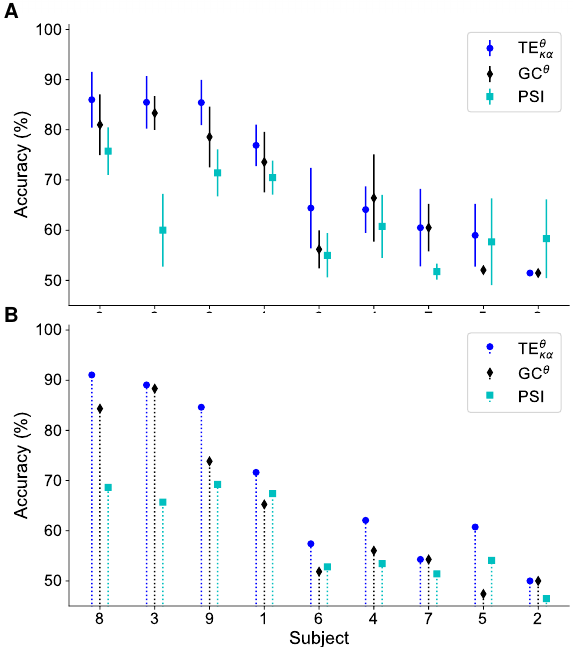
Figure 7. ( A ) Highest average classification accuracy for each subject in the MI database during the training-validation stage. ( B ) Accuracies obtained for each subject during the testing stage. The subjects are ordered from highest to lowest performance according to the accuracies obtained for the TE θ κα -based classifier in the training-validation